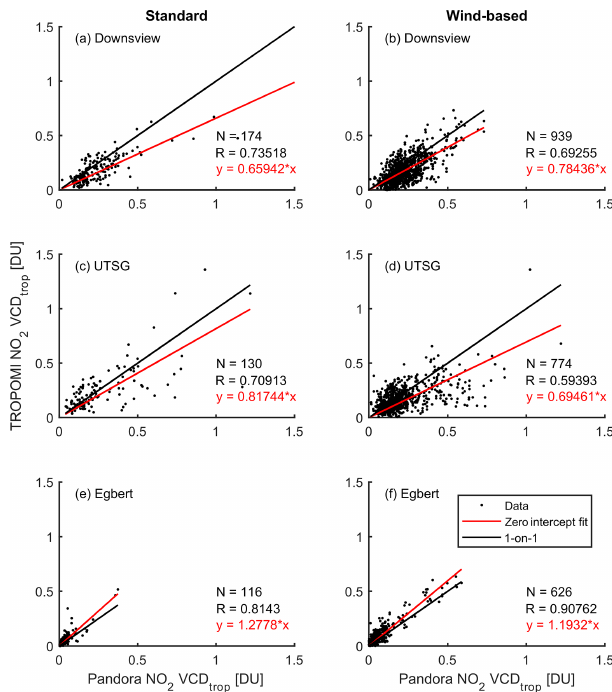
Figure C3. TROPOMI ECCC NO 2 VCD trop vs. Pandora NO 2 VCD trop